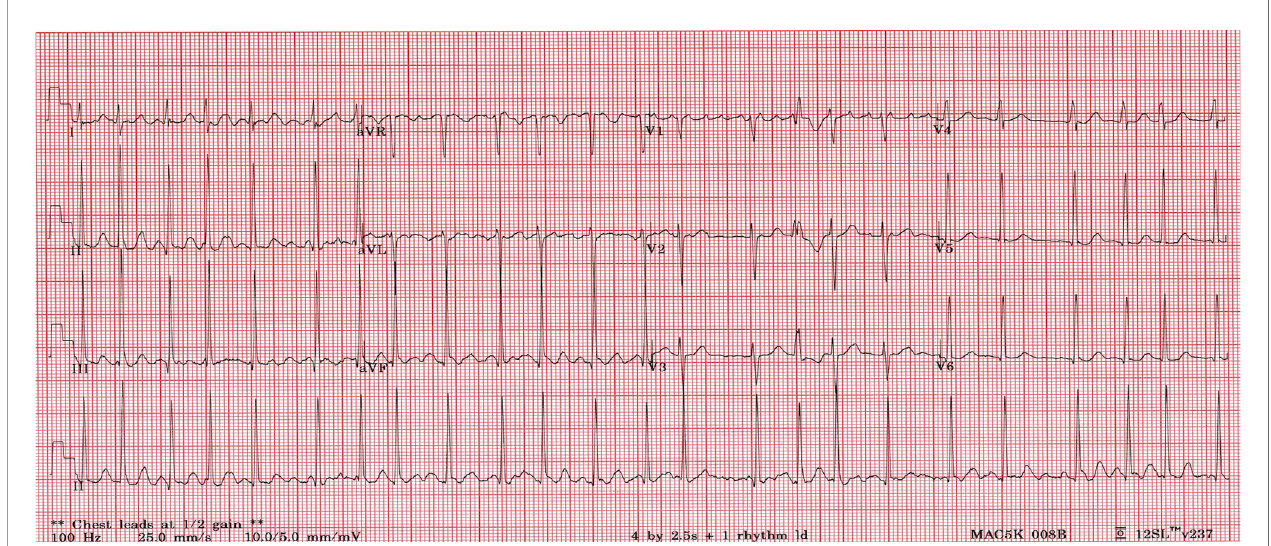
FIGURE 1 | 12 lead ECG demonstrating AF with variable conduction and left ventricular hypertrophy.